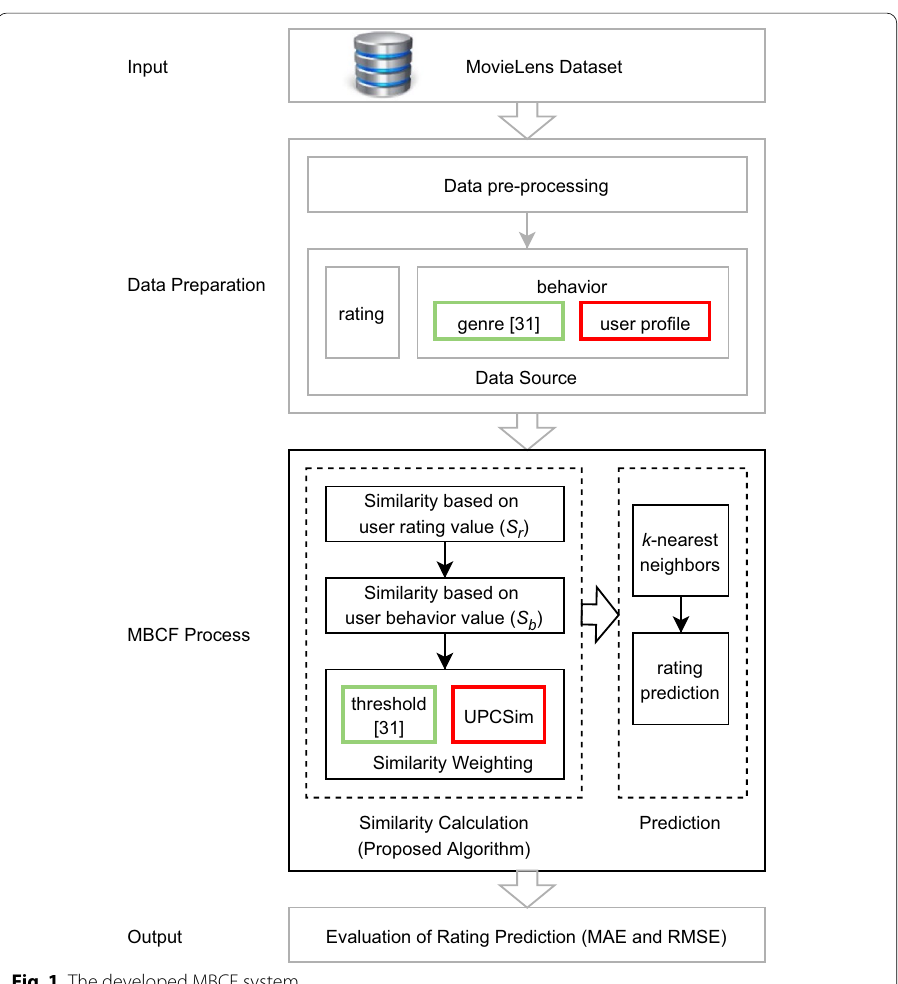
Fig. 1 The developed MBCF